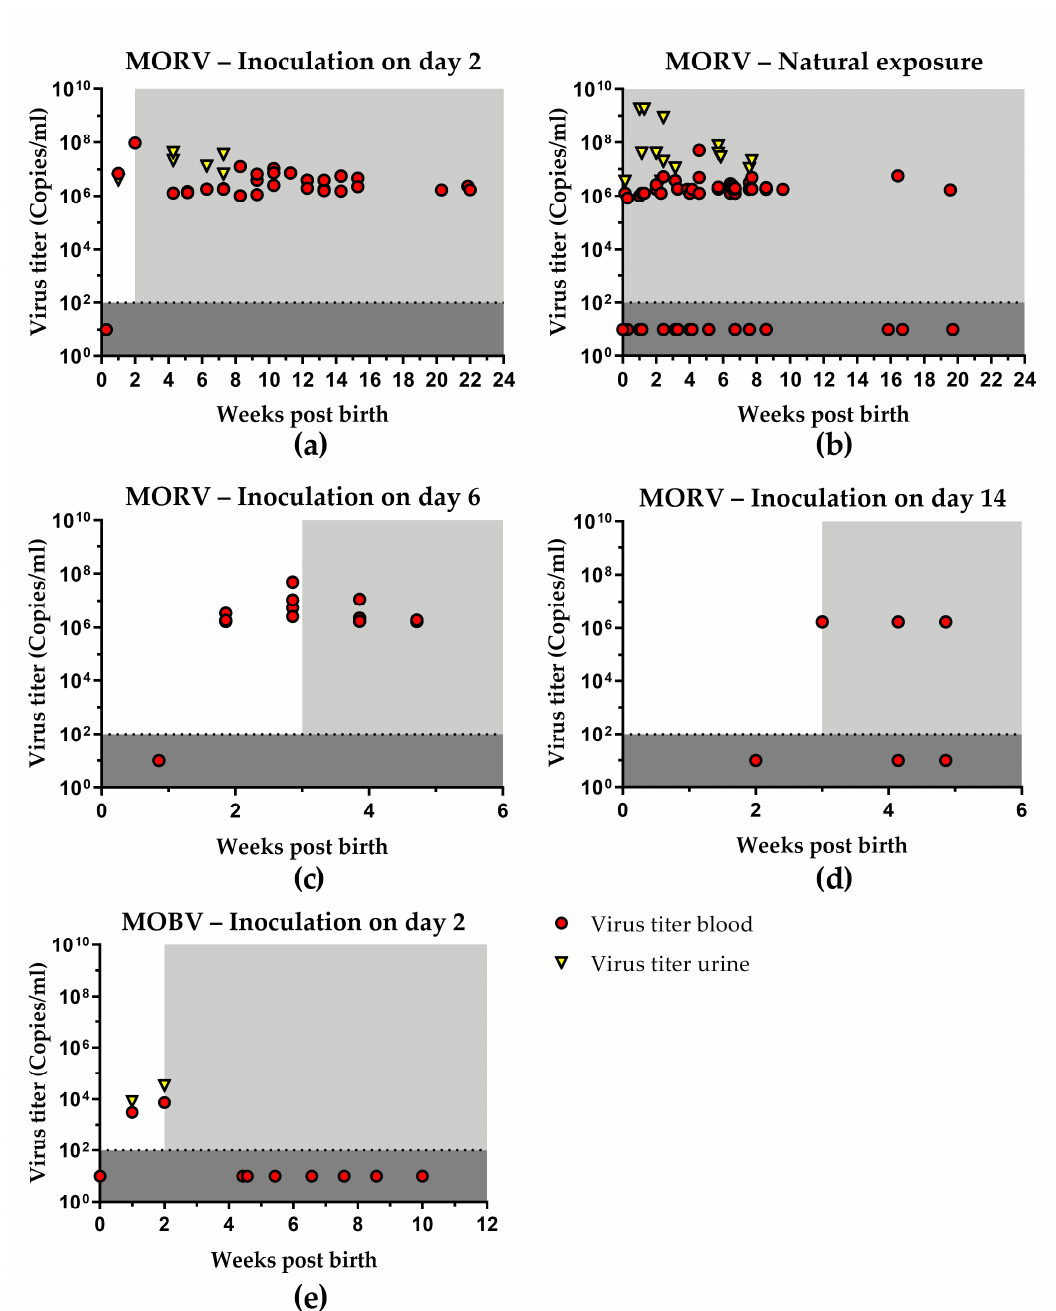
Figure 1. Virus titers in blood and urine of infected Mastomys . Neonates were inoculated with MORV at the age of 2 days ( a ) or exposed to the virus ( b ) via direct contact with infected individuals. Furthermore, Mastomys were inoculated with MORV at 6 days ( c ) or 14 days ( d ) post-birth. ( e ) Neonates were inoculated with MOBV at the age of 2 days. Blood and urine were collected at regular intervals and tested for the presence of MORV or MOBV RNA with qRT-PCR. Ct values were converted into copy numbers using a standard curve. Blood samples are depicted as red dots and urine samples were indicated by yellow triangles. Plasma was inactivated and analyzed for the presence of MORV- or MOBV-specific antibodies with indirect immune fluorescence. The presence of virus-specific antibodies is marked by the light grey area. The limit of detection for the qRT-PCR assay is shown by the dotted line and dark grey coloration. Negative samples have been assigned a default value below the detection